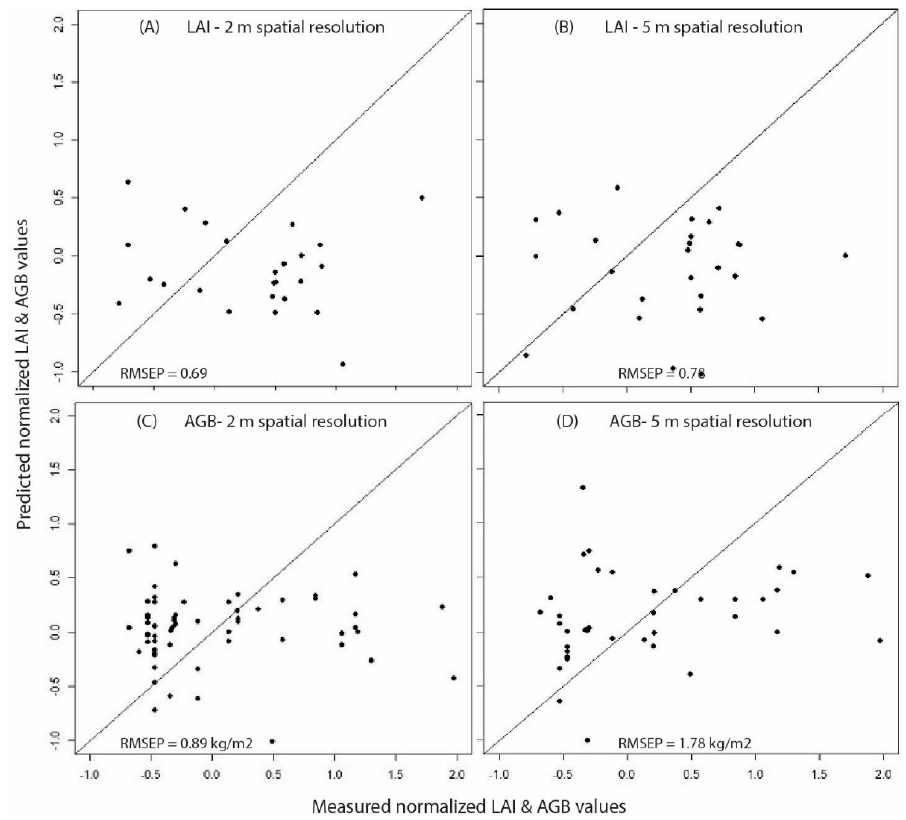
Figure 4. Cross-validated predictions for the normalized leaf area index (LAI) and above ground biomass (AGB): ( A ) predicted versus field measured normalized LAI with 2-m spatial resolution predictor variables; ( B ) predicted versus field measured normalized LAI with 5-m spatial resolution predictor variables; ( C ) predicted versus field measured normalized LogAGB with 2-m spatial resolution predictor variables; ( D ) predicted versus field measured normalized LogAGB with 5-m spatial resolution predictor variables. (RMSEP, root mean square error of prediction).